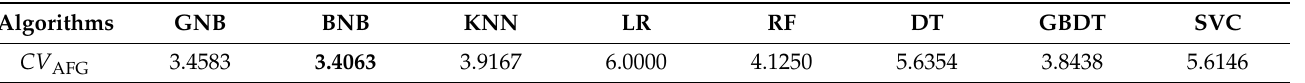
Table 3. Mean ranking scores of eight machine learning models with CV AFG on 48 imbalanced datasets. Bold values indicate the best machine learning model for each row.